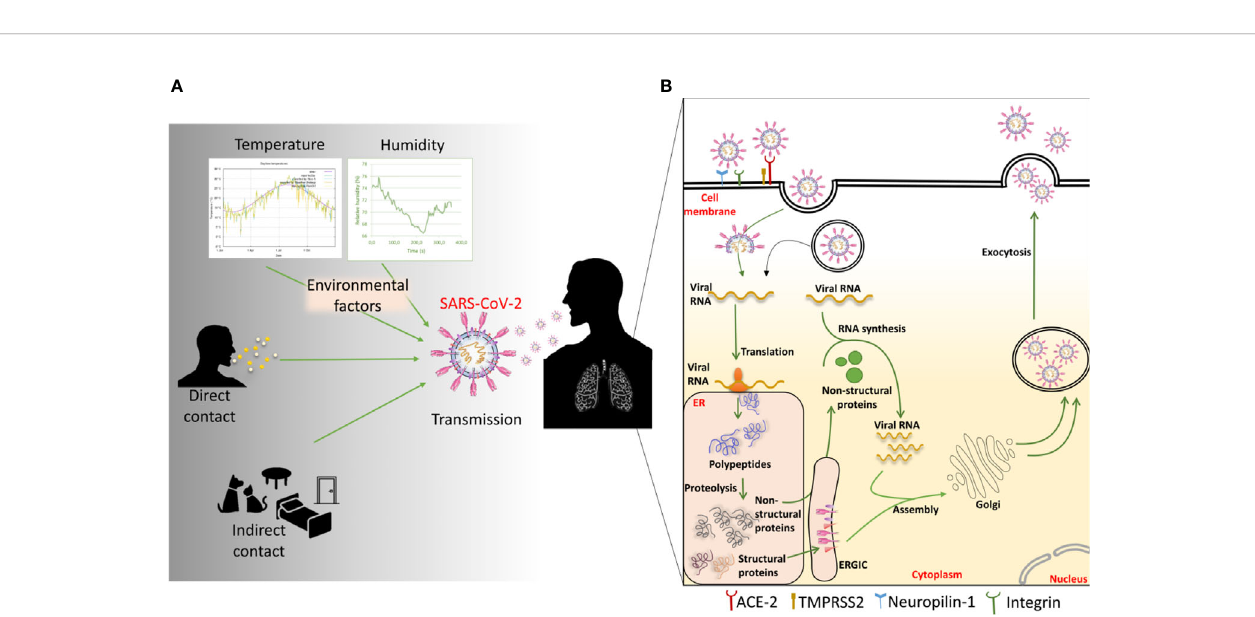
FIGURE 4 | (A) Factors involved in SARS-CoV-2 transmission and (B) mechanism of SARS-CoV-2 entry into the host cell. The transmission of SARS-CoV-2 occurs through various direct and indirect routes. Environmental factors like temperature and humidity show the impact on the transmission. Once the virus enters inside the host, it enters into the cell through angiotensin-converting enzyme 2 (ACE-2). It can also use various other cell surface receptors like neuropilin-1 to facilitate the entry and infectivity. By the membrane fusion or endosomal pathway, the virus releases its genetic material inside the cytoplasm. The viral RNA then gets transcribed and translated into polypeptides. The polypeptides are cleaved to generate various structural and non-structural proteins (nsps). The nsps help in viral replication and transcription. The more viral RNA copies are produced through the replication. Meanwhile, the structural proteins like E, M, and S proteins get embedded in the endoplasmic reticulum (ER) membrane and transported to Golgi through ER-Golgi intermediate complex (ERGIC). The multiple numbers of new virions are then assembled and exocytosed of the cell to infect nearby